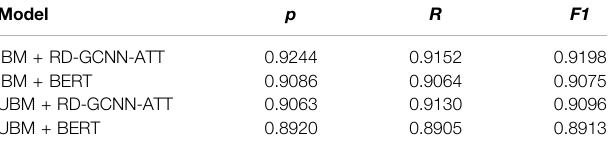
TABLE 9 | Results of the model experiment.